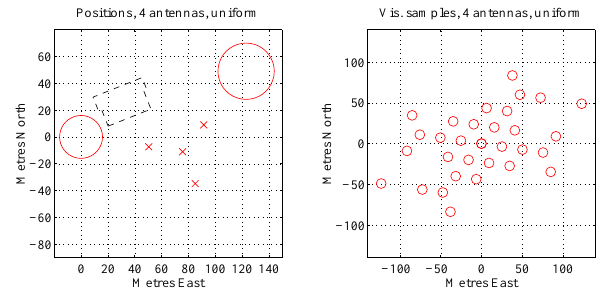
Fig. 4. A configuration for four passive receiving antennas, in the same format as Fig. 2. In this case, one antenna is placed at the centre of an equilateral triangle with the two existing antennas at two of the vertices, as before, and three passive antennas form another equilateral triangle concentric with the outer triangle, with side length one-third of the large triangle. The images obtained using this setup are shown in Fig.